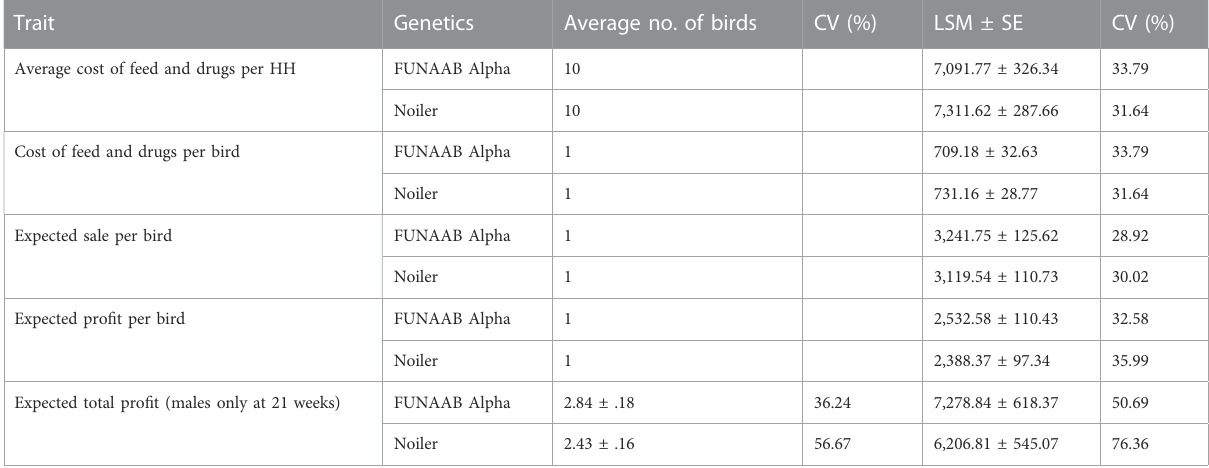
TABLE 7 Effect of genetics on pro fi tability (LSM ± SE) of the improved smallholder chicken intervention.